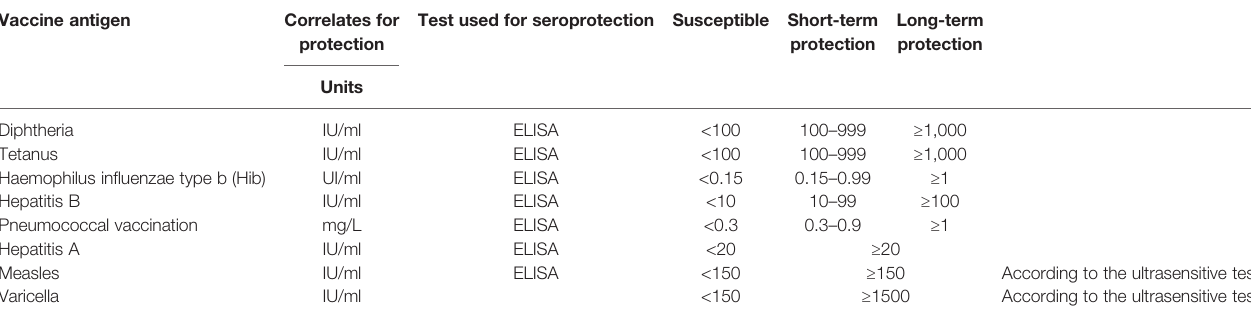
TABLE 5 | Correlate of protection for vaccine preventable diseases (4,